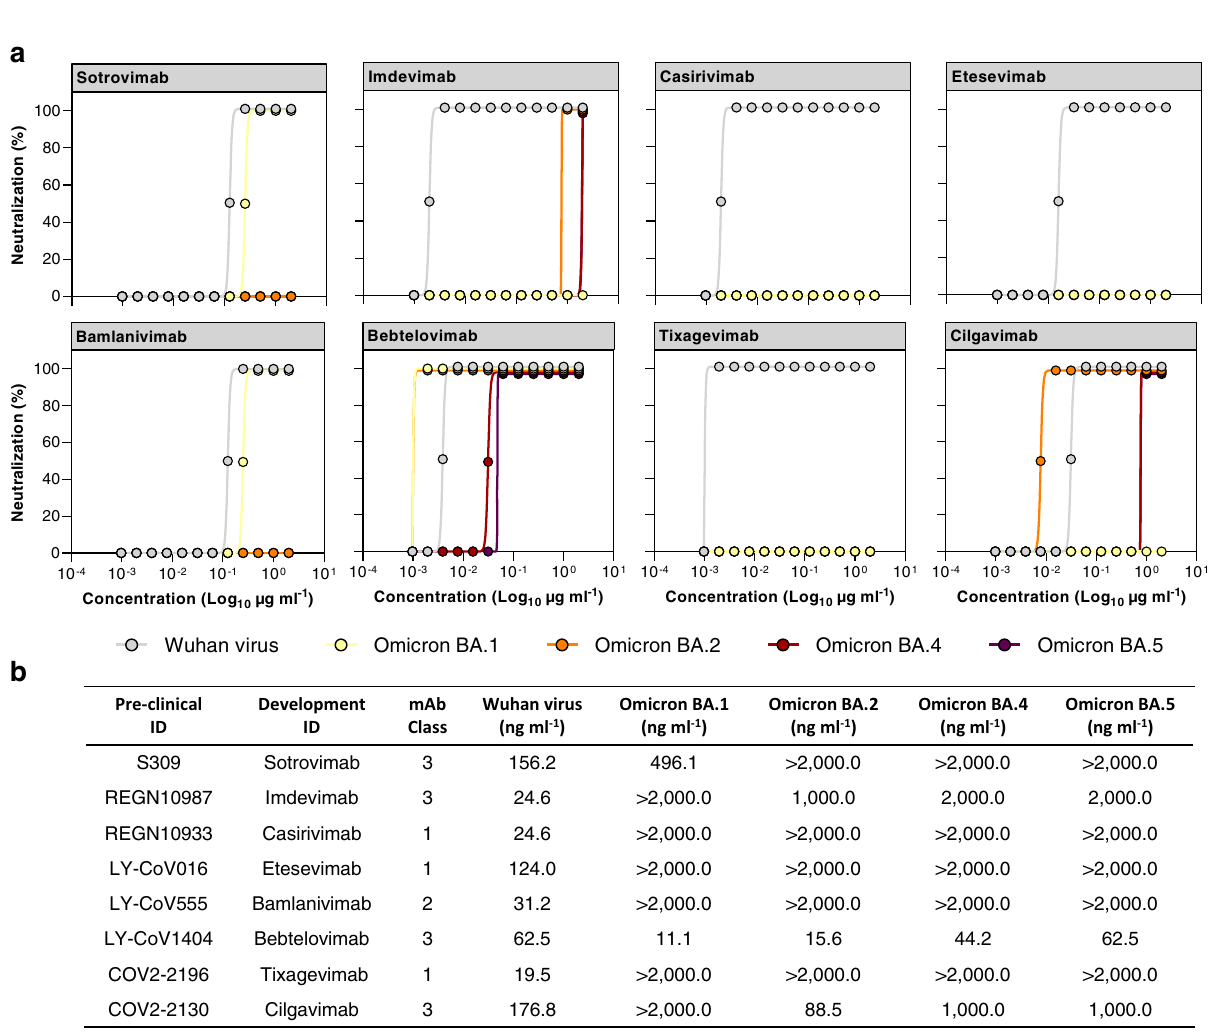
Fig. 3 | IGHV;IGHJ gene usage of Omicron cross-neutralizing antibodies. Heat- maps and alluvial plots display the antibody IGHV;IGHJ gene rearrangements fre- quencyforeachsingledonorsandforpullednAbsrespectivelyforSN2( a ),SN3( b ) and SP2 ( c ). The heatmap on the left represents germline frequency for each individualsubject.Inthealluvialplots,V-Jgenerearrangementswerehighlightedif they represented at least 10% of all antibodies able to cross-neutralize a speci fi c Omicron variant. Below this threshold, several germlines showed identical or similar frequency values and therefore were not considered as predominant. Selected germlines were highlighted as light blue (IGHV1-69;IGHJ4-1, IGHV3- 30;IGHJ6-1, IGHV3-53;IGHJ6-1, IGHV3-66;IGHJ4-1), dark blue